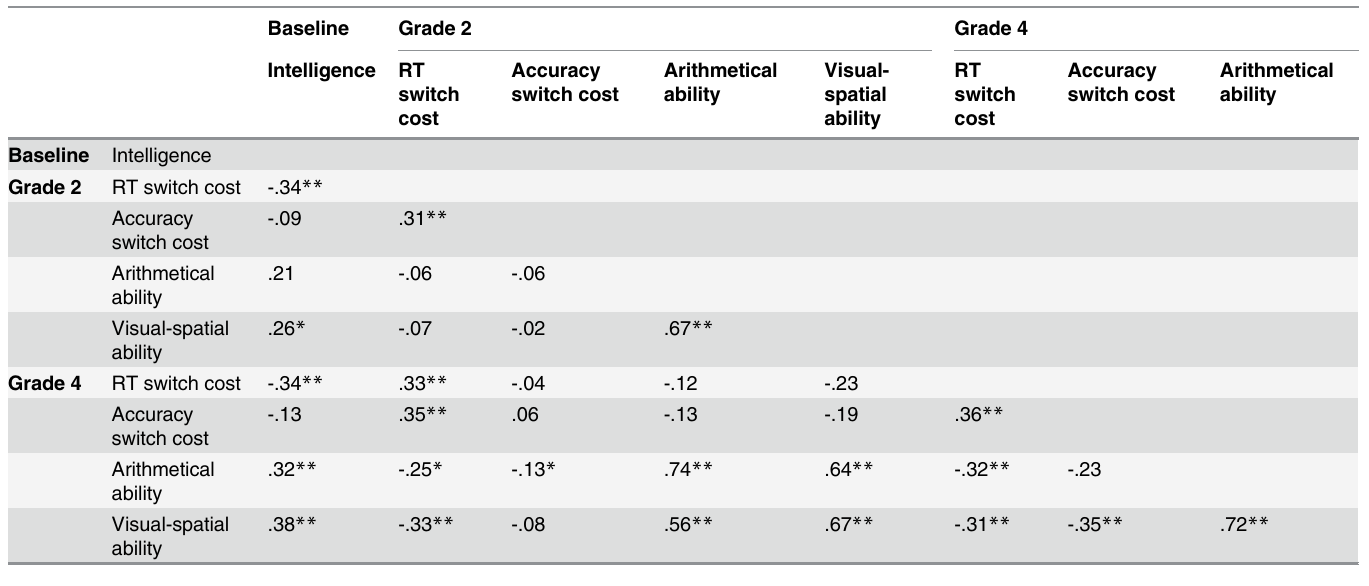
Table 3. Correlations among study